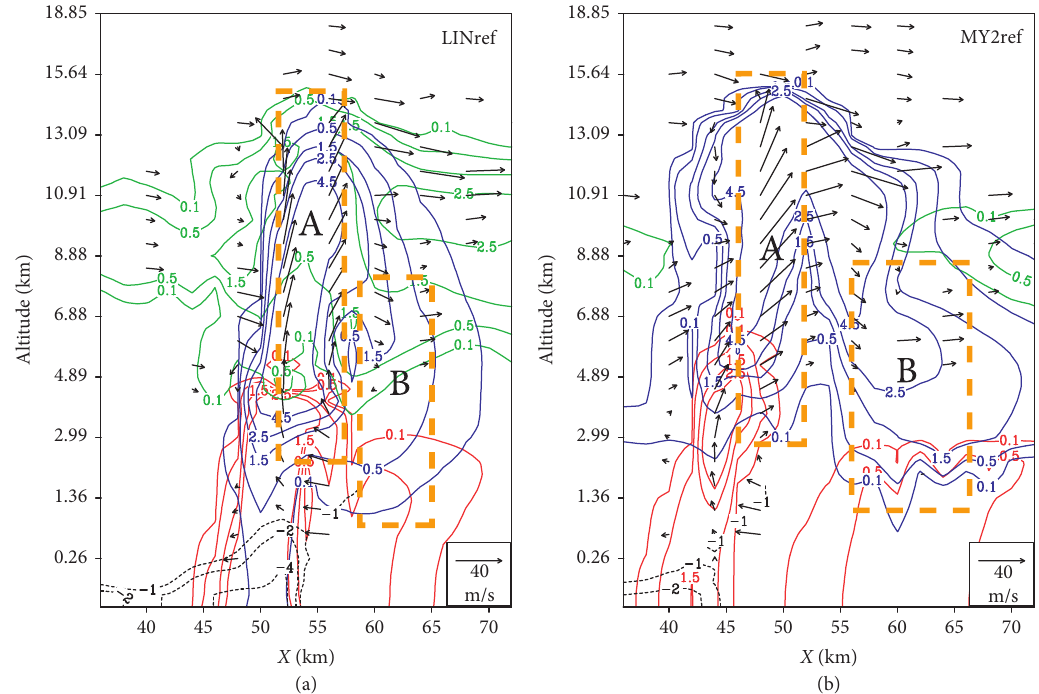
Figure 3: Vertical cross-sections of q r (red), q s (green), q h (blue), perturbation potential temperature (black contour), and wind (vector, for the absolute vertical velocity greater than 1.0m · s − 1 ) at T � 2h in the X - Z plane along (a) y � 60km and (b) y � 58km for (a) LINref and (b) MY2ref, respectively. Both X - Z planes cross the maximum updraft centers in supercell. Area A denotes the updraft core; area B denotes the hail falling outside the updraft